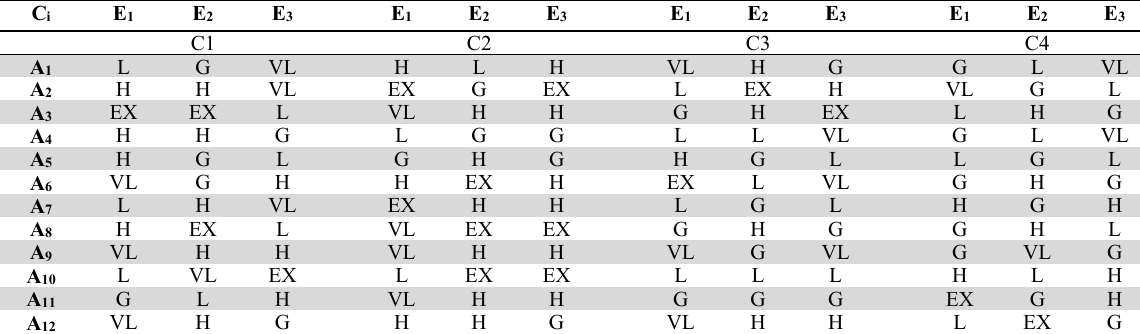
Experts ratings with Linguistic terms